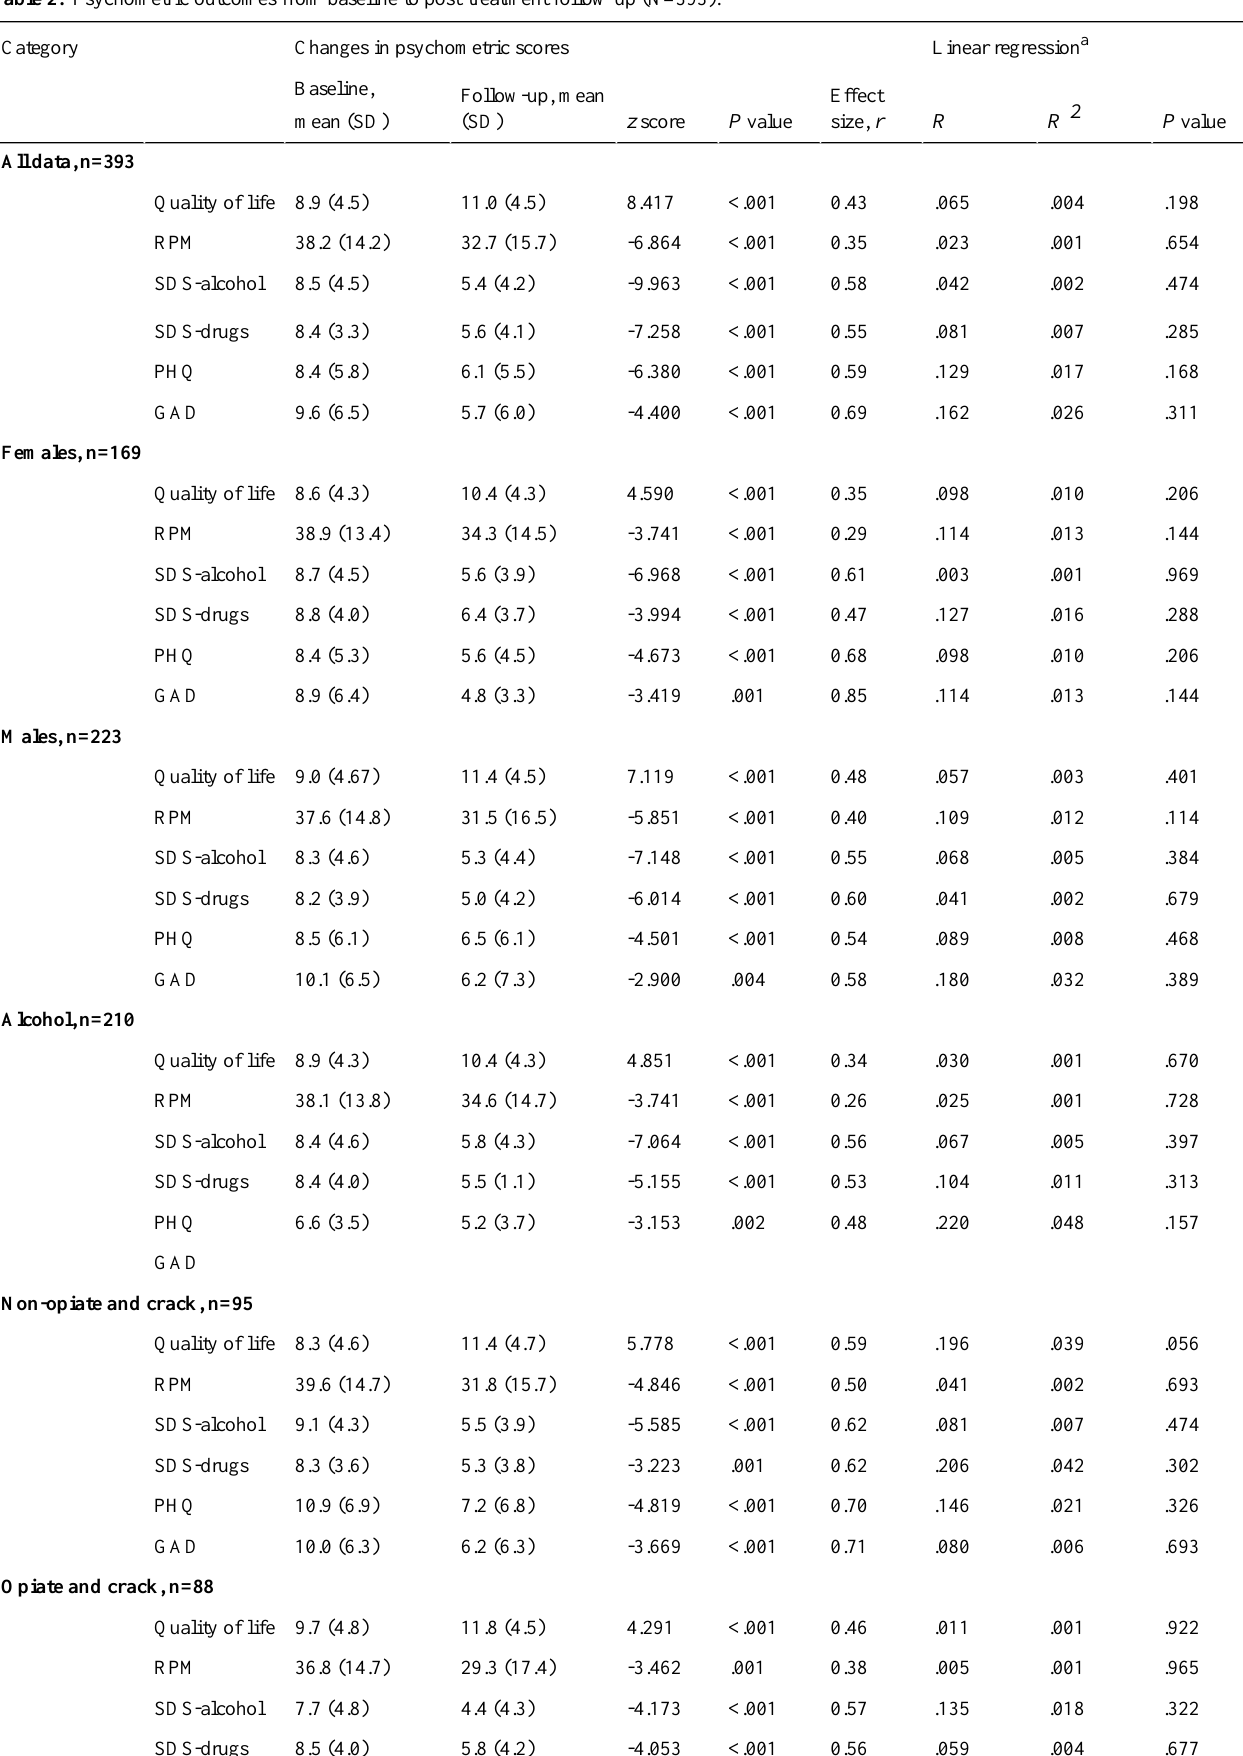
Table 2. Psychometric outcomes from baseline to post-treatment follow-up (N=393).